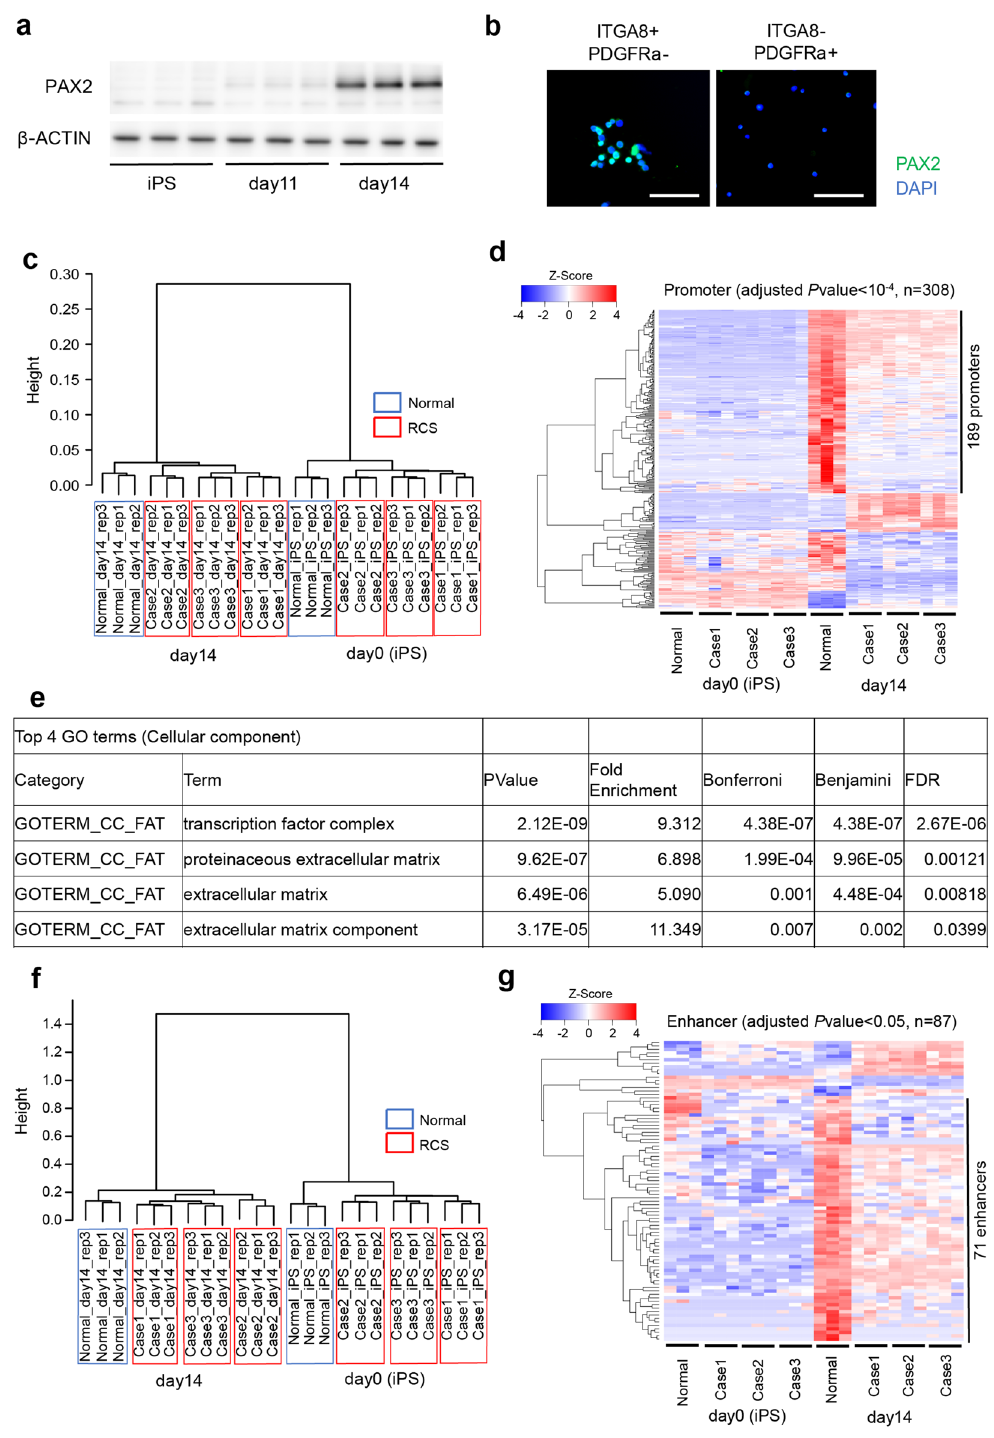
Figure 3. Cap analysis of gene expression (CAGE) analysis during induction to kidney lineage cells. ( a ) Western blots for PAX2 and β-ACTIN during induction from iPSCs to nephron progenitor cells. ( b ) Immunocytochemistry of PAX2 expression in each indicated sorting sample from control iPSCs. The scale bars represent 100 μm. ( c ) Promoter usage profiles of differentiated nephron progenitor cells derived from control and RCS-iPSCs were evaluated using cluster analysis at the indicated time points of culture. Each donor sample was tested in triplicate at each time point. ( d ) Promoter usage profiles of differentiated nephron progenitor cells derived from control and RCS-iPSCs cultured for 14 days were evaluated using heat map analysis. A total of 189 promoters that are differentially activated by the healthy donor compared to patients are arrayed and clustered according to the activation pattern as shown by the dendrogram on the left. ( e ) Results of gene ontology and pathway analysis by The Database for Annotation, Visualization, and Integrated Discovery. The list identifies functional annotations of a subset of differentially expressed genes. ( f ) Enhancer usage profiles of differentiated nephron progenitor cells derived from control and RCS-iPSCs were evaluated using cluster analysis at the indicated time points of culture. ( g ) Enhancer usage profiles of differentiated nephron progenitor cells derived from control and RCS-iPSCs cultured for 14 days were evaluated using heat map